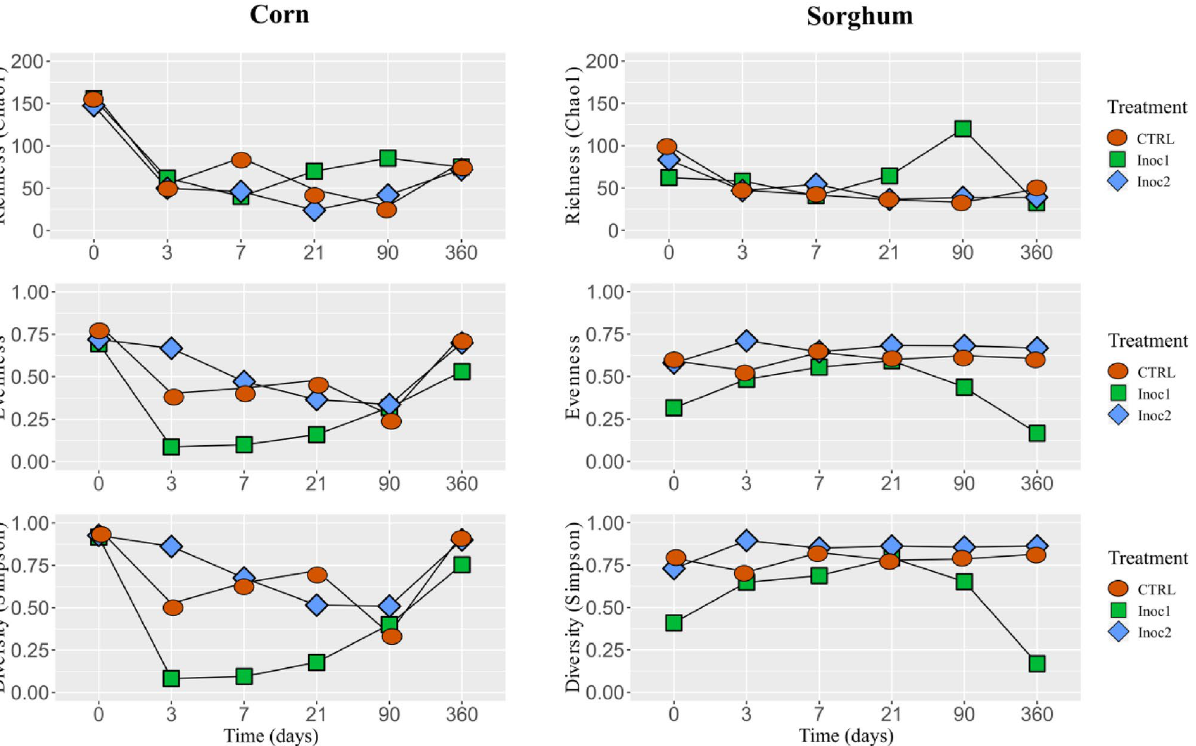
Figure 1. Chao 1 Richness, evenness and Simpson diversity of rehydrated corn and sorghum grain silages throughout the fermentation period (0, 3, 7, 21, 90 and 360 days). CTRL non-inoculated, Inoc1 Lactobacillus